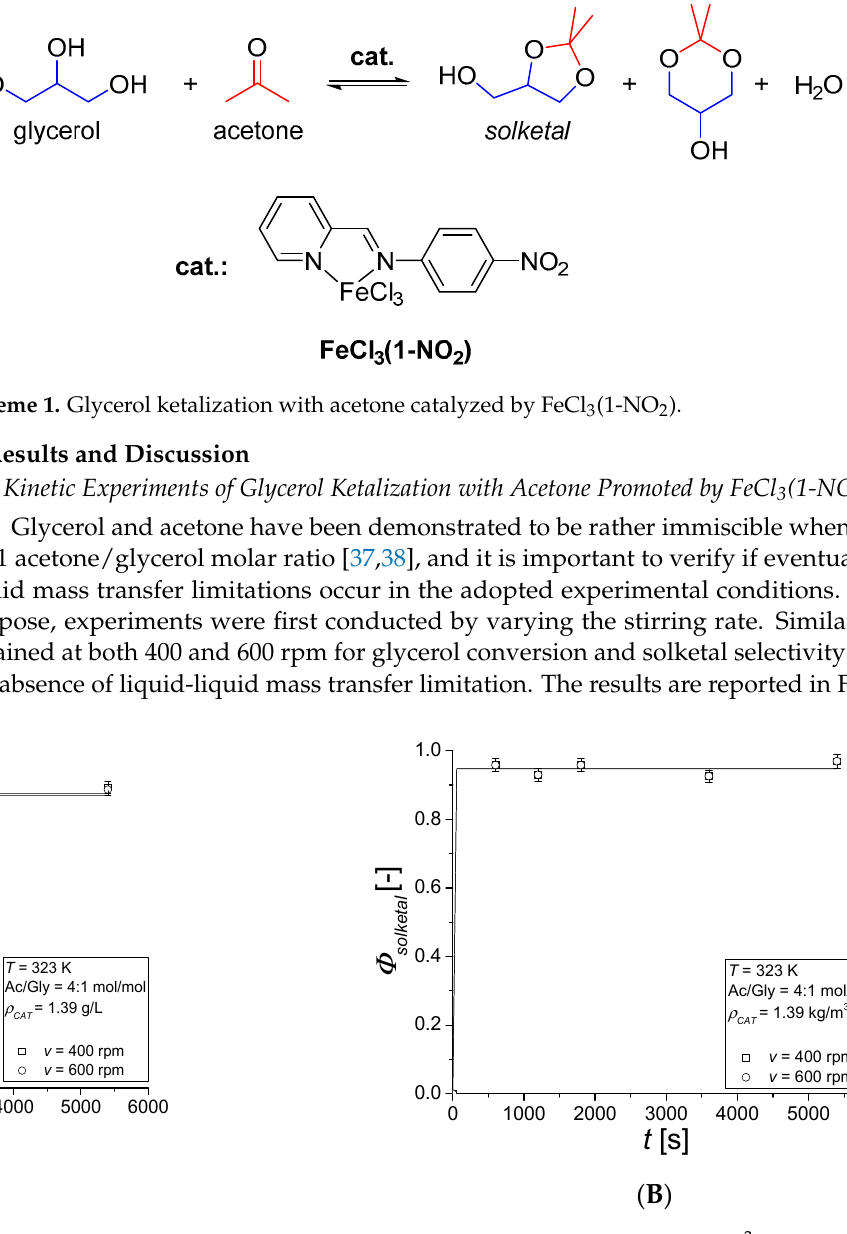
Figure 1. Stirring rate effect for catalyzed tests, fixing T = 323 K, Ac/Gly = 4:1 mol/mol, and ρ CAT = 1.39 kg/m 3 . ( A ) Glycerol conversion. ( B ) Selectivity toward solketal.